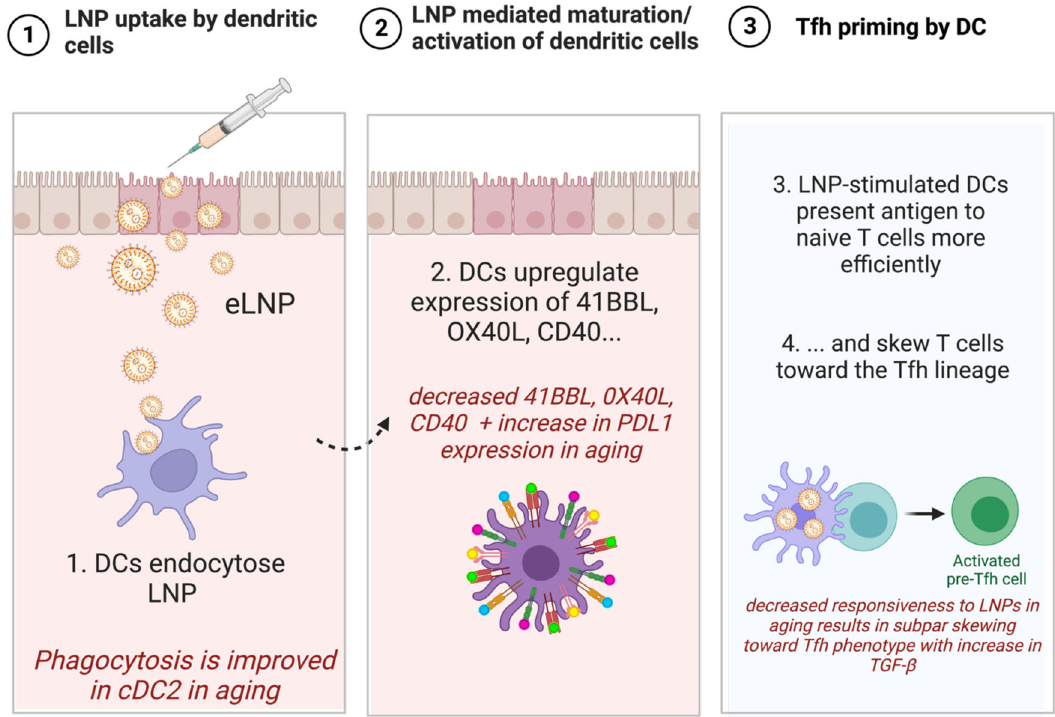
Fig. 8 Lipid nanoparticles (LNP) can activate the innate immune response sans mRNA (eLNP). eLNP will upregulate co-stimulatory makers on the surface of monocytes, DCs, and PBMCs that are necessary for T cell activation and antigen-processing and presentation. eLNP will then induce a productive humoral and cellular response. In older adults, however, eLNP upregulates the same co-stimulatory but to a much lesser degree while also upregulating PD-L1, an inhibitory marker that was all but absent in younger adults. Addition of eLNP also induced TGF-B production in older adults. Taken together, our study shows a mechanism that accounts for the decreased protection due to vaccination in older